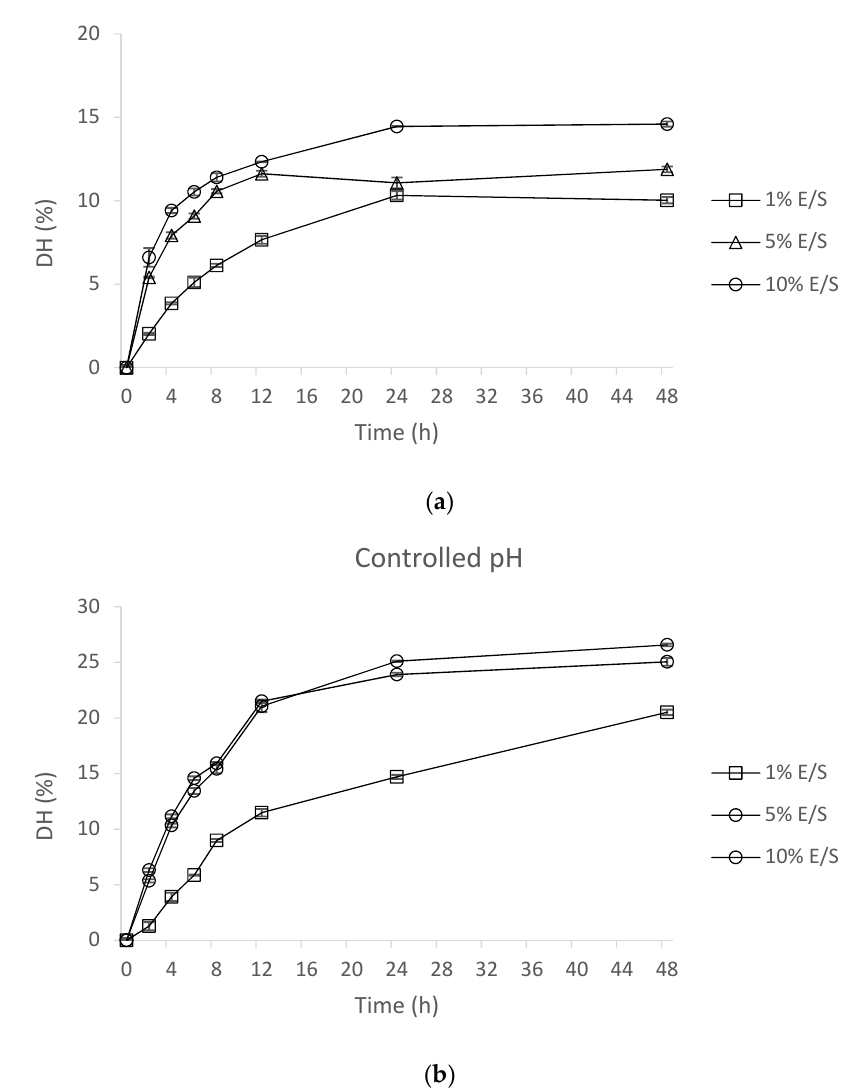
Figure 2. Hydrolysis curves (DH vs. time) of PDF with ( a ) 1% E/S ratio and ( b ) 5% E/S ratio under different pH conditions. The symbols correspond to the values obtained experimentally while the lines are drawn for illustration purposes.